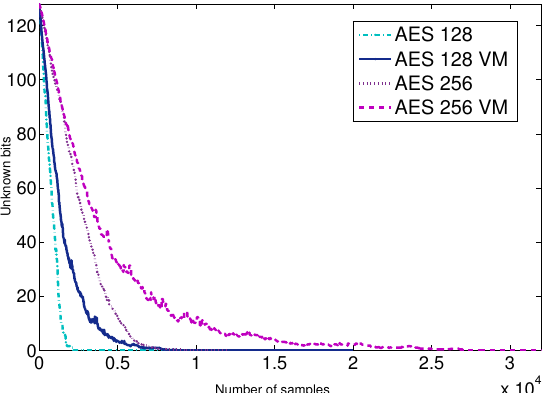
Figure 6. Key bits that remain unknown after each encryption for the Flush+Reload technique.